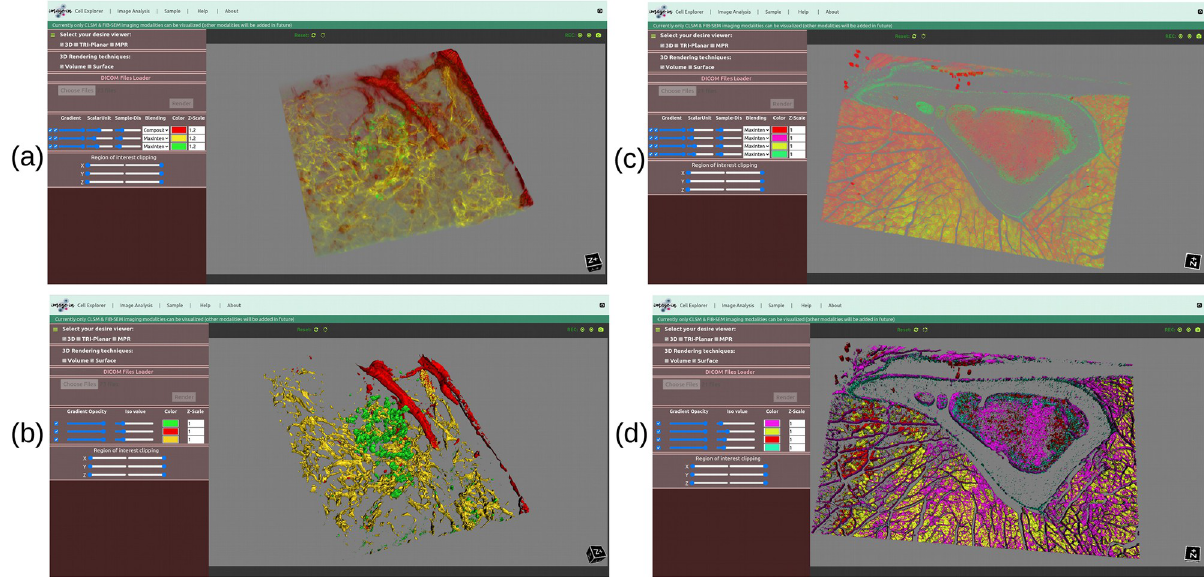
Fig 10. The three-channel human islet microvasculature [42] and four-channel tibia bone tissue [BL6-SEC5] [27] CLSM dataset is rendered in both (a, c) volume and (b, d) surface rendering views. In each view, each channel is rendered in a different color.